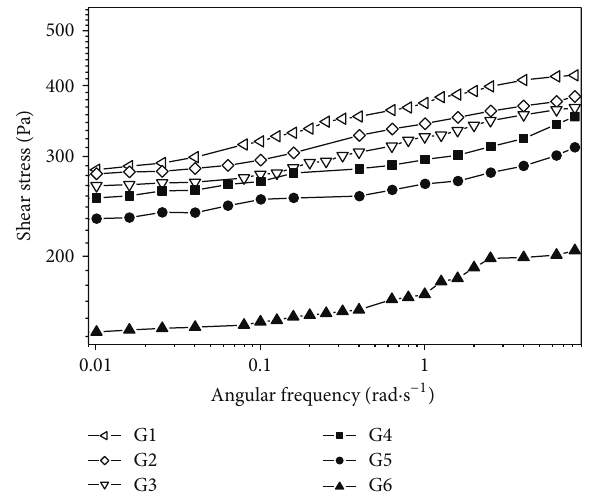
Figure 3: Apparent viscosity of the hydrogels versus concentration of the neutralizer NaOH.